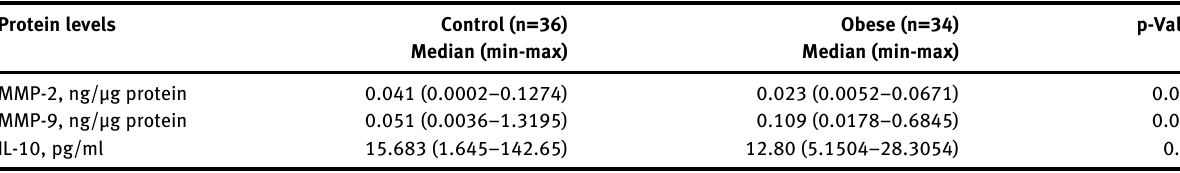
Table  : Comparison of MMP-  , MMP-  and IL-  protein levels obese patients and controls. Protein levels